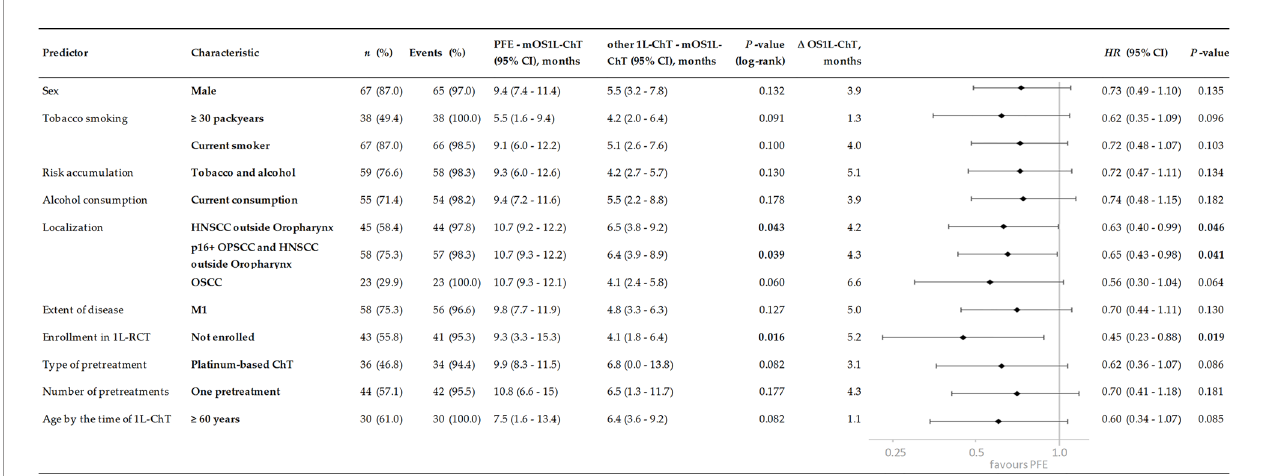
FIGURE 4 | Subgroups of incurable recurrent/metastatic head and neck squamous cell carcinoma bene fi tting from PFE administered according to the EXTREME protocol by prolonged OS 1L-ChT , demonstrated by Kaplan – Meier estimates applying log-rank tests and univariate Cox proportional hazard regression. P values of signi fi cant predictors <0.05 are in